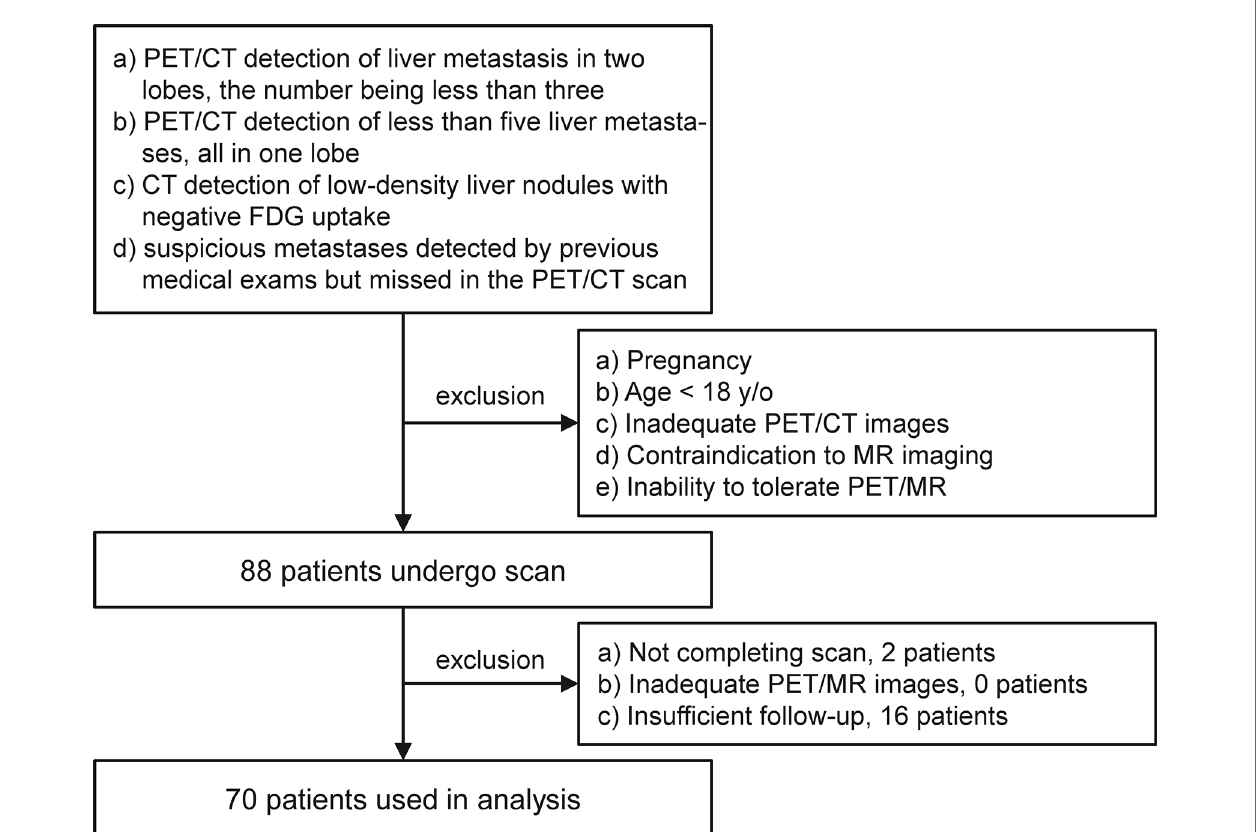
FIGURE 1 | The enrollment and exclusion